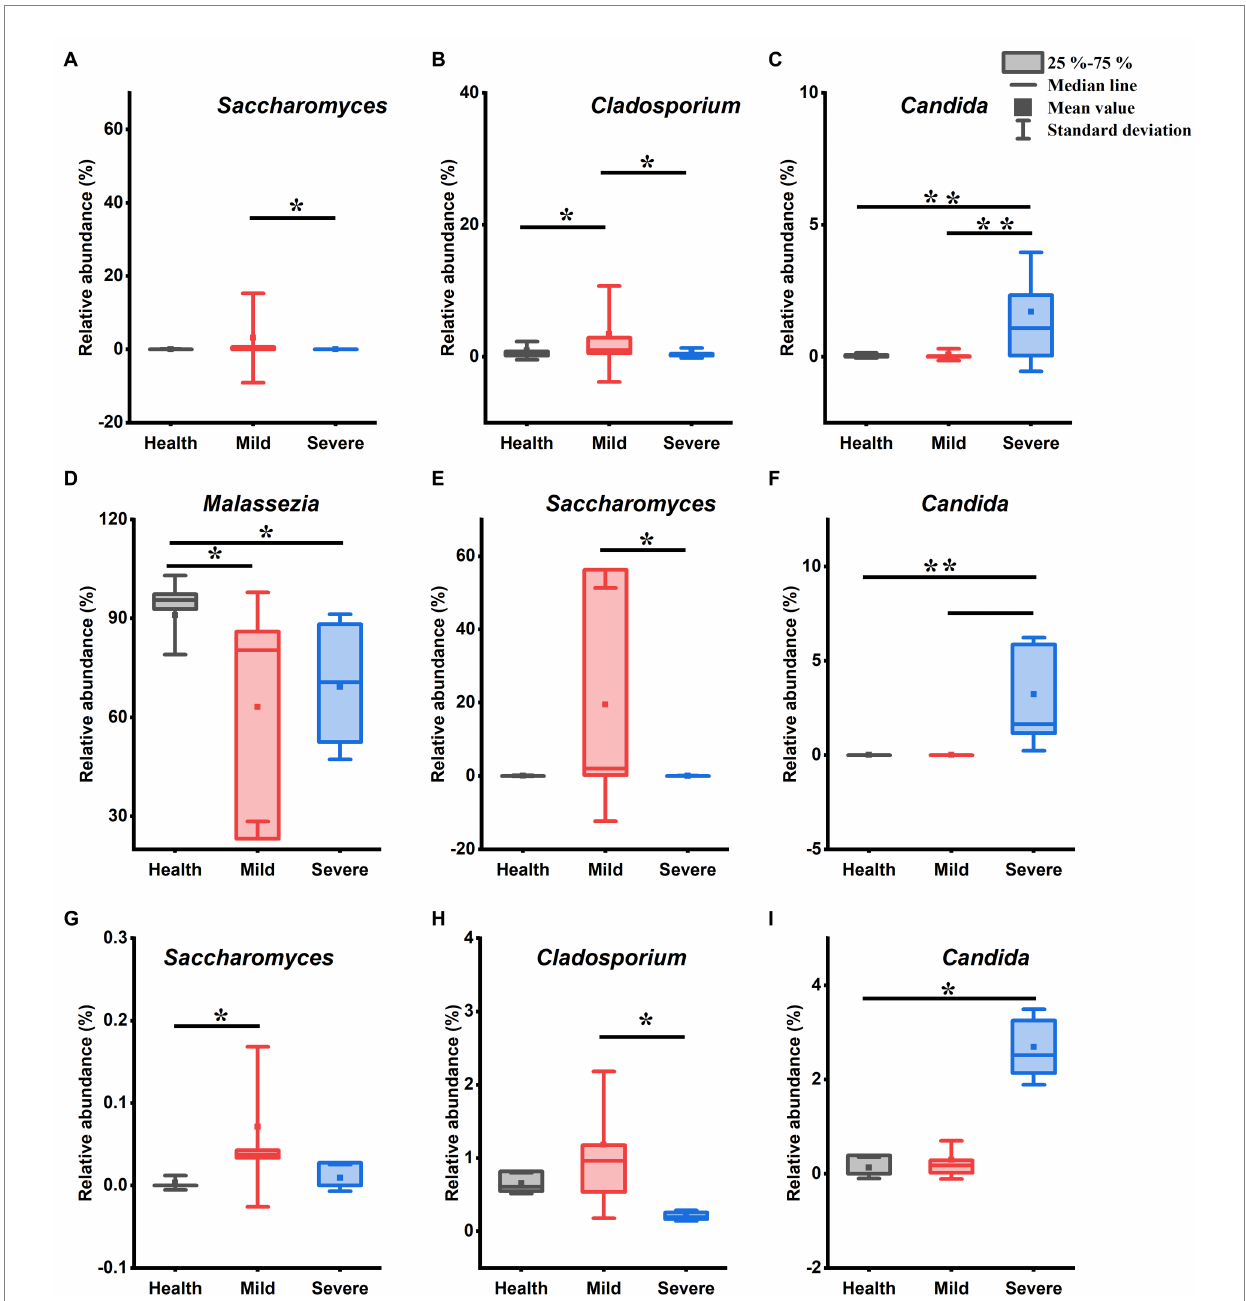
FIGURE 4 The genus with statistical difference between groups in the fungal flora. (A–C) Samples from all sites; (D–F) samples from cheek; (G) samples from chin; (H,I) samples from chest and back. *0.01 < p < 0.05, significant difference; ** p < 0.01, highly significant